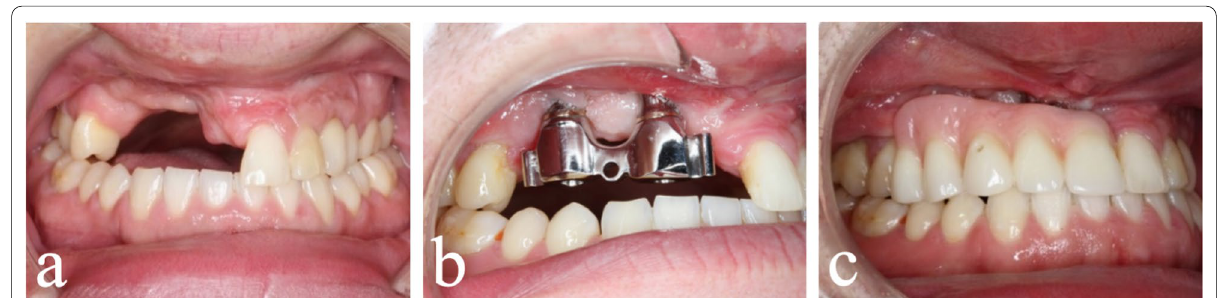
Fig. 6 Treatment path to final prosthodontic restoration. Clinical images showing failure of a bone augmentation and the compensated dental arches and the compromised hard and soft tissues ( a ). Final prosthodontic restoration using a bar retained removable partial denture ( b – c